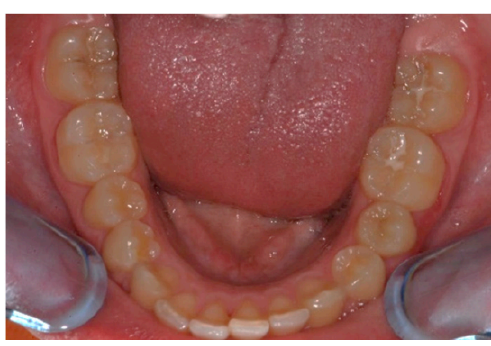
Figure 1. Upper anterior segments.